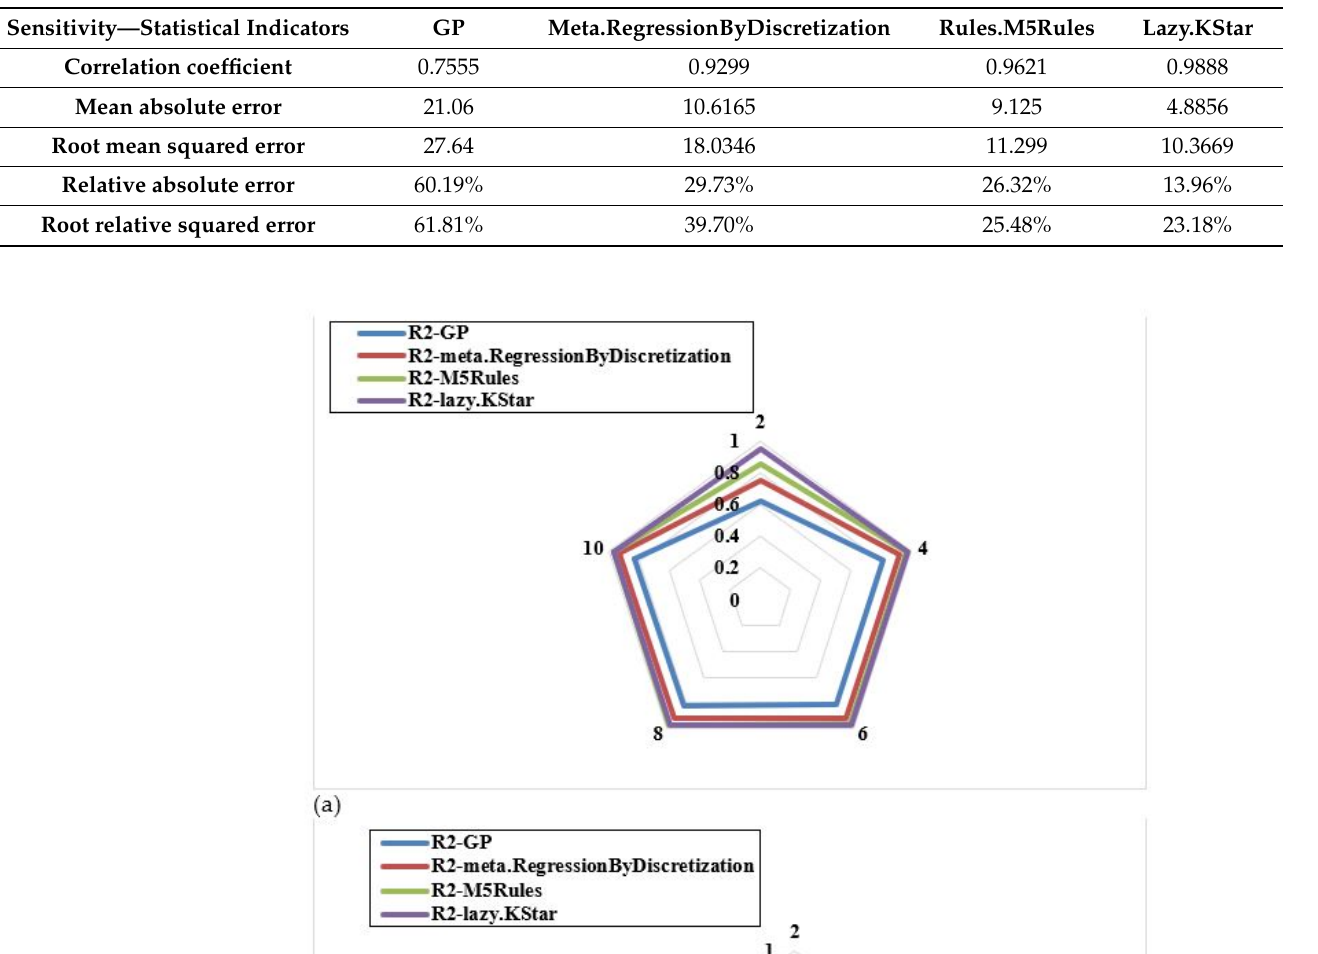
Table 6. The statistical indicators of artificial intelligence practices based on the sensitivity function.